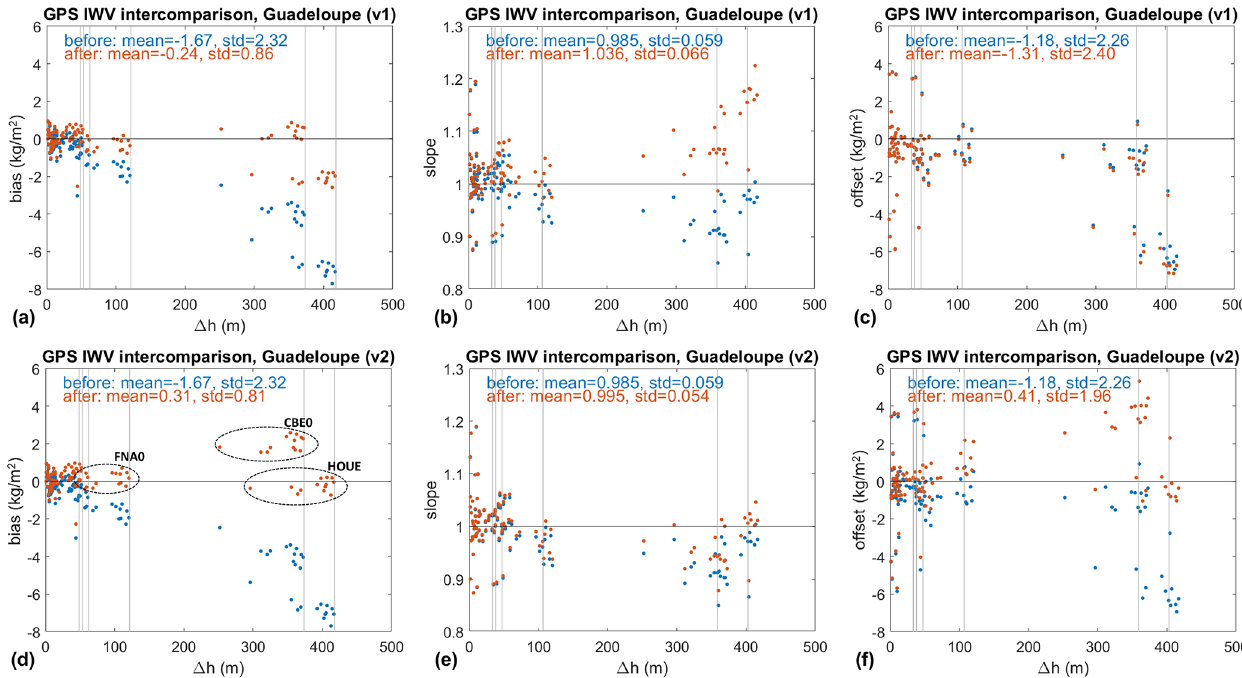
Figure 8. Variation in (a, d) bias, (b, e) slope, and (c, f) offset estimated from pairs of GPS stations as a function of inter-station height difference, (cid:49)h . The blue dots correspond to the results before correction, and the red dots correspond to the results after correction, with (a– c) the scaling model, v1, and (d–f) the proposed model fitted from a radiosonde climatology, v2. The results include 105 inter-comparisons with positive height differences from a total of 15 GPS stations located over the Guadeloupe archipelago for the period from 1 January to 29 February 2020. The vertical grey lines indicate the stations that have elevations above 50m, namely FNA0 (122m), CBE0 (374m), and HOUE (418m), the comparisons of which are also highlighted by ellipses in Fig.